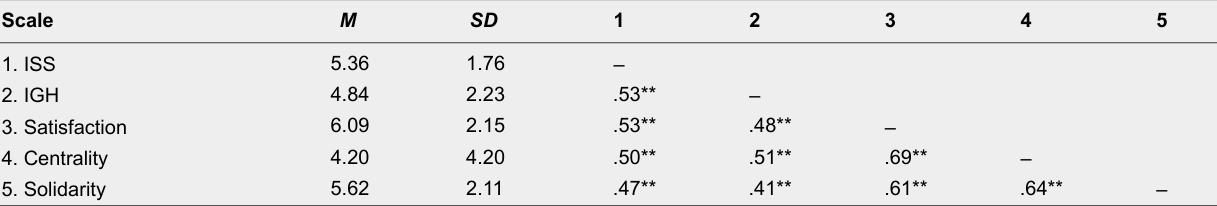
Convergent Validity: Bivariate Correlations With Group Identity Scale (Study 1) ISS .40**.63** IGH .32**.55** -Satisfaction .74** Cetrality .51**.76** Solidarity